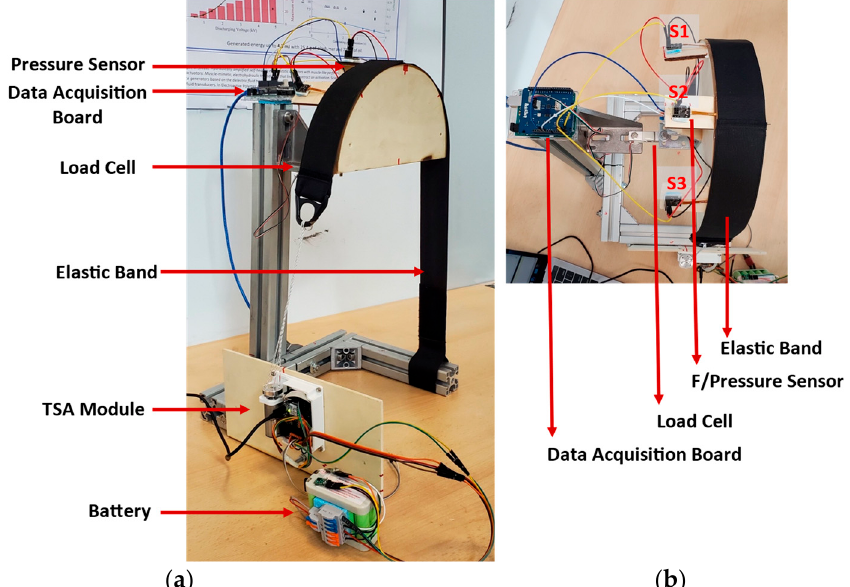
Figure 3. Testbed for contact force modeling. ( a ): Isometric view showing the actuator module, battery, bands and data acquisition board; ( b ): Top view with three single point pressure/force sensors.